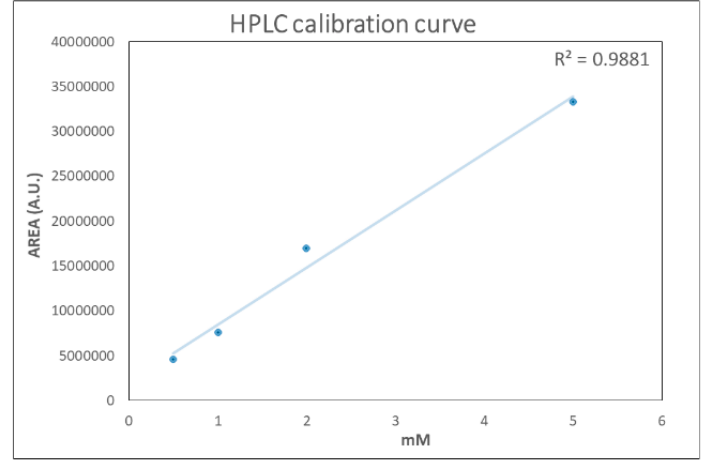
Figure 4. HPLC calibration curve in the range 0.5–5 mM.